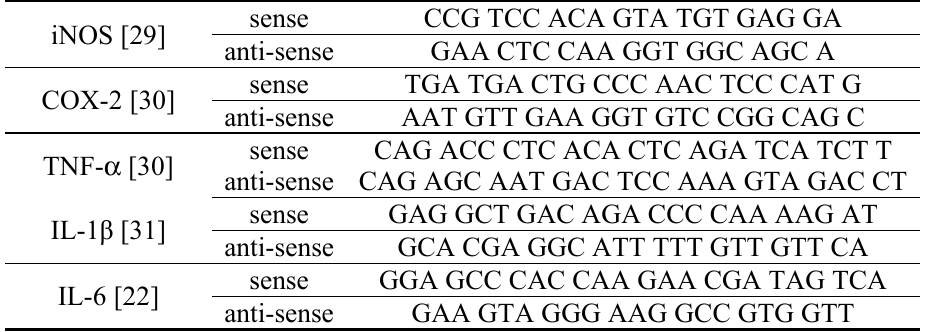
Table 1. Primer sequences used for